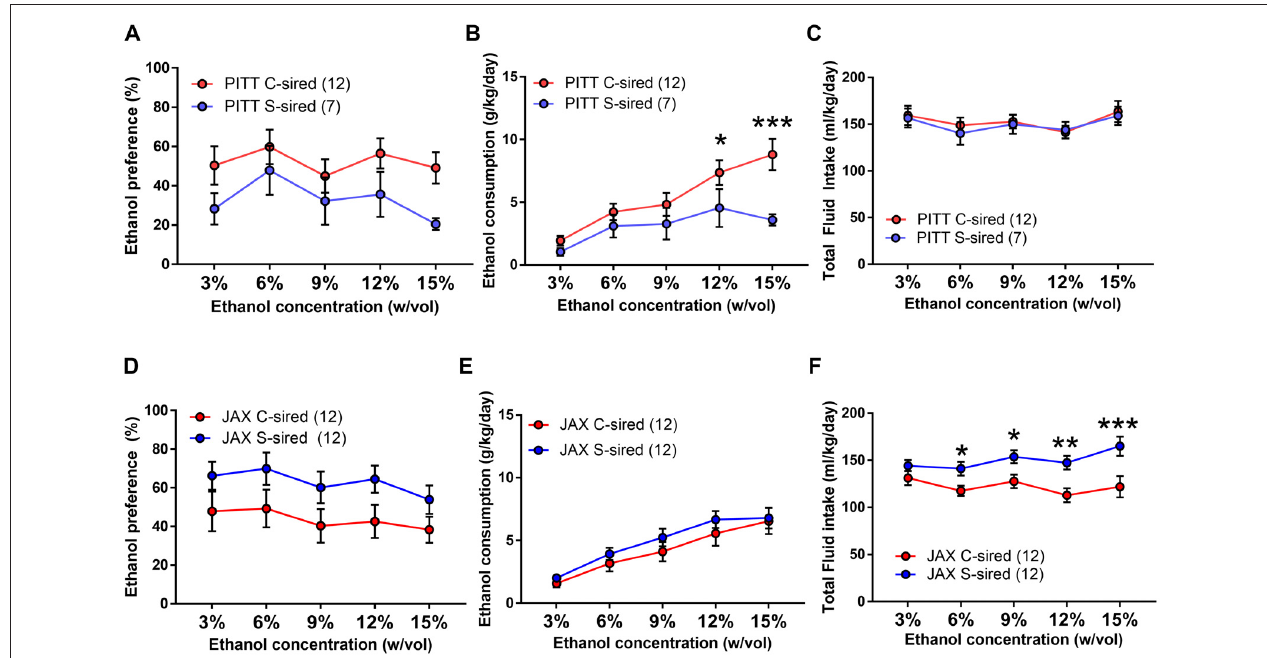
FIGURE 9 | Paternal stress reduces ethanol drinking selectively in PITT S-sired offspring. (A) No change in ethanol preference of PITT S-sired male offspring. (B) Significant reduction in ethanol consumption in PITT S-sired male offspring. (C) No effect of paternal stress on total fluid intake in PITT sired male offspring. No effect of paternal stress on ethanol preference (D) or consumption (E) in JAX-sired male offspring. (F) Significant reduction in total fluid intake in JAX S-sired male offspring ( N = 12/JAX groups and 7–12/PITT groups). ∗ p < 0.05, ∗∗ p < 0.01, ∗∗∗ p > 0.001.